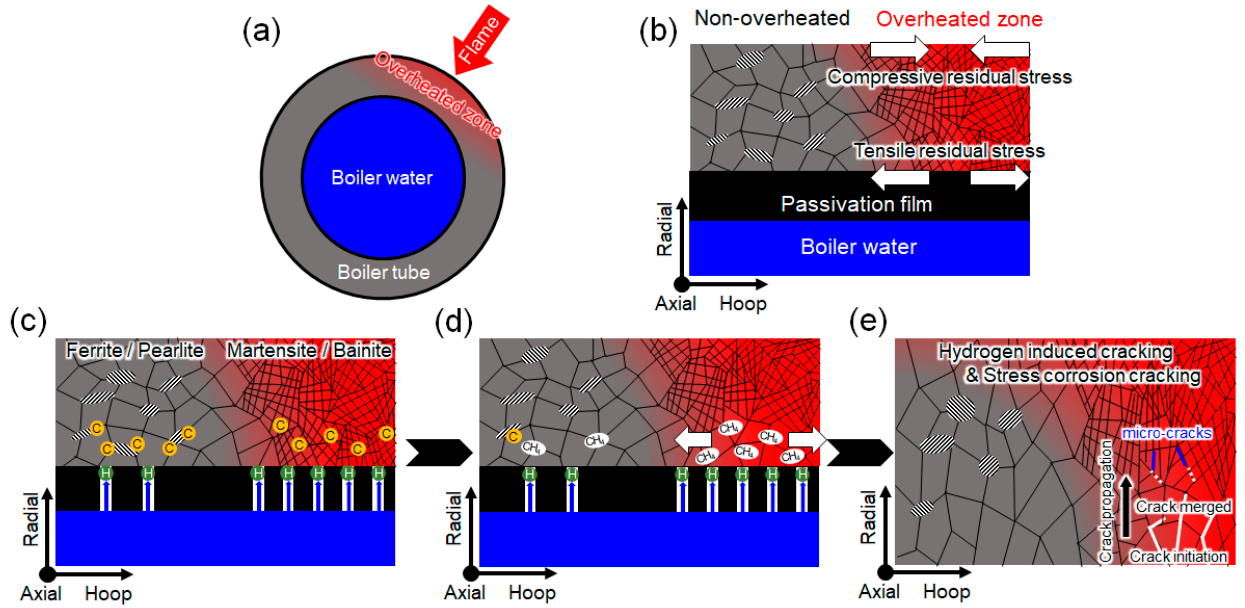
Figure 8. Crack initiation and failure mechanism for the water wall tube boiler: ( a ) the initial state of the tube, ( b ) the development of residual stress, ( c ) the penetration of hydrogen, ( d ) decarburization, and ( e ) crack initiation and propagation.